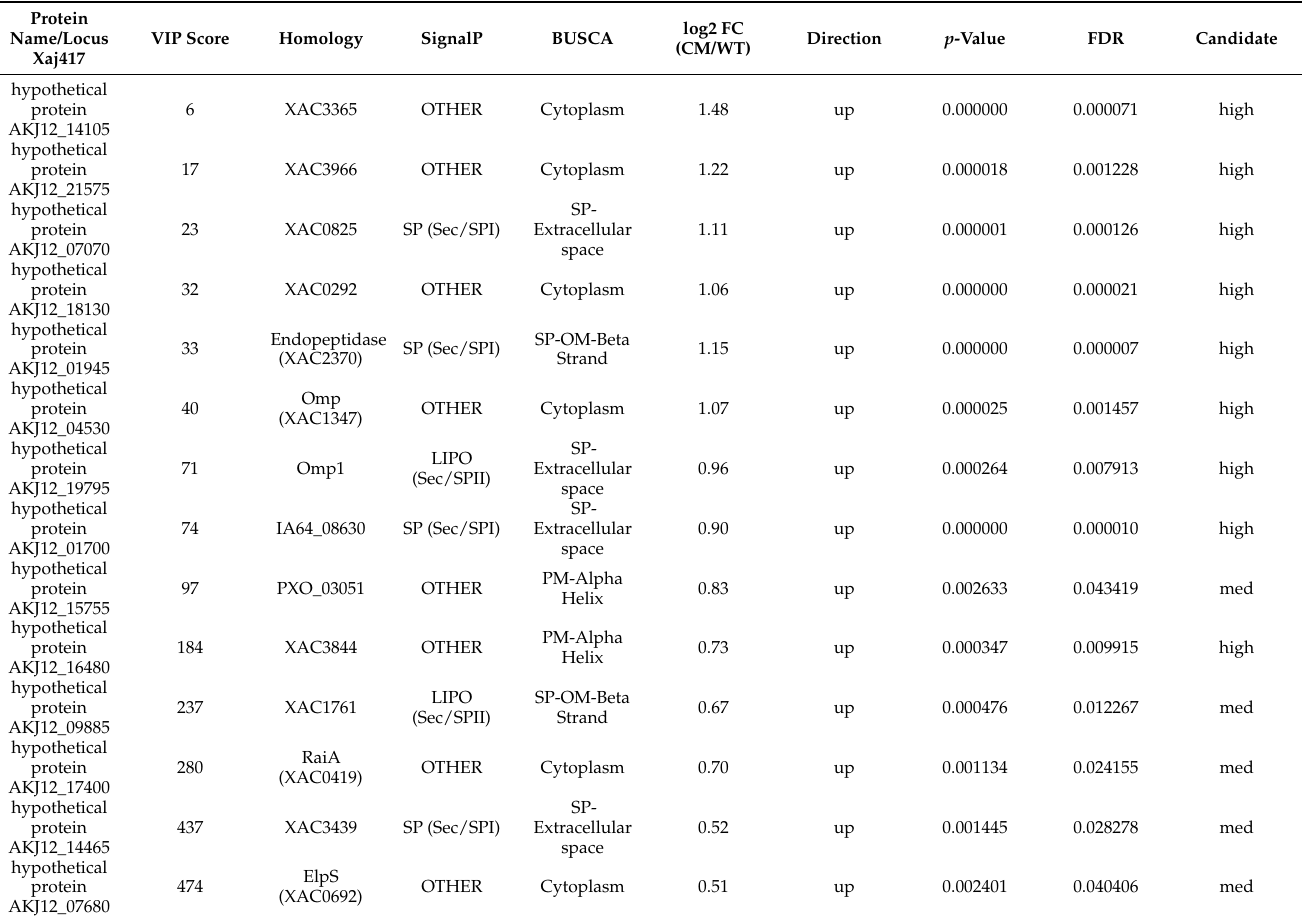
Table 1. Differentially abundant hypothetical proteins in XajCM compared to